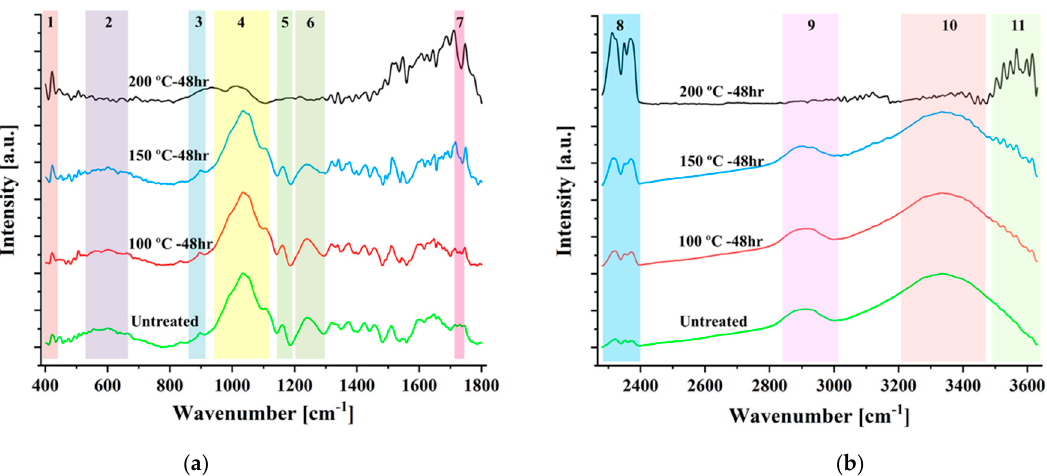
Figure 7. FTIR spectra of untreated and thermally modified bamboo at three different temperatures for a 48-h duration in two specific ranges, namely: ( a ) 400–1800 cm − 1 and ( b ) 2280–3600 cm − 1 .